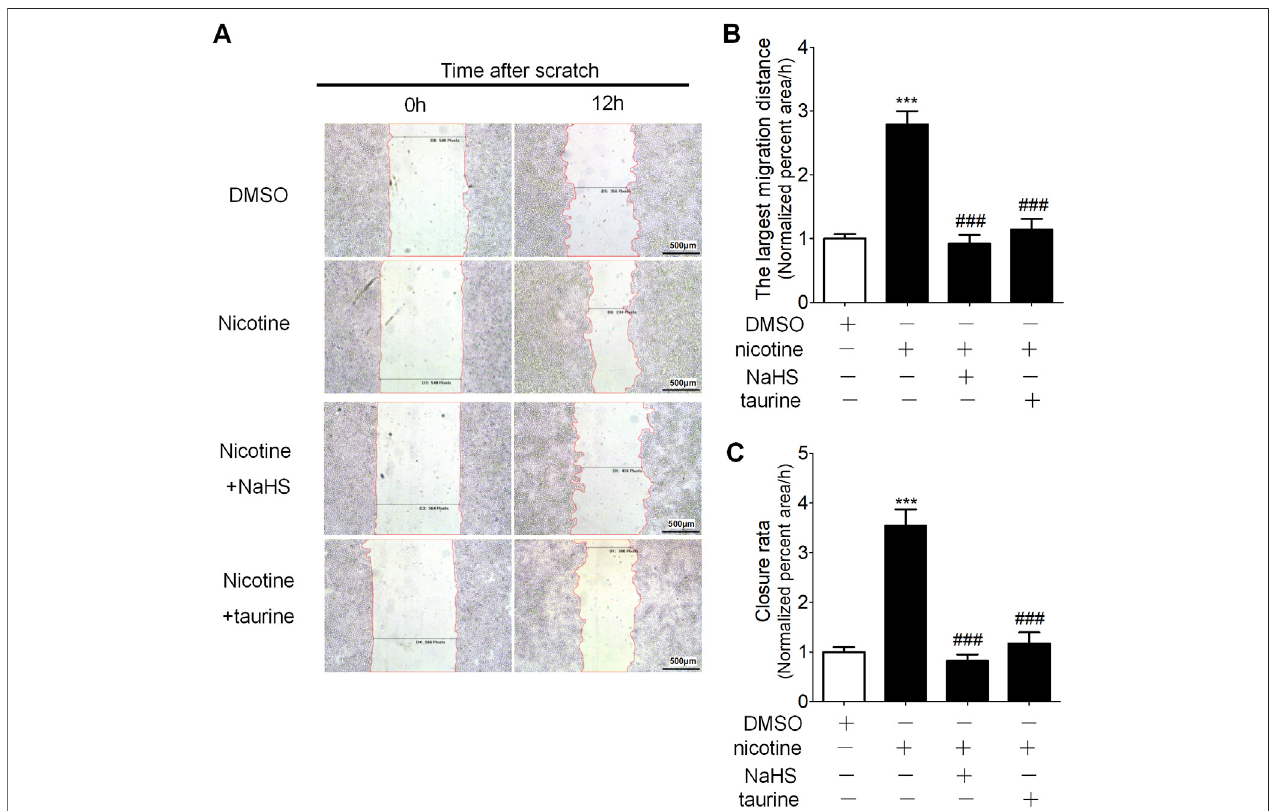
FIGURE 6 | NaHS and ER stress inhibitor taurine reduced nicotine-induced enhancement of cell migration ability in 16HBE cells. (A) Wound healing assay on the migrationof16HBEcells.Thepercentageofthewoundhealingwascalculatedasthelargestmigrationdistance(theshortestwidthofwoundat0 h — theshortestwidth of the wound at 12 h/the width of the wound at 0 h) and the closure rate (the area of the wound at 0 h — the area of wound at 12 h/the area of the wound at 0 h). (B,C) The largest migration distance and the closure rate calculated by IPP software after wound healing assay. Results are presented from 6 independent experiments ( n = 6, respectively, in each group). Values are expressed as mean ± SEM. *** p < 0.001 vs. the DMSO group. ### p < 0.001 vs. nicotine